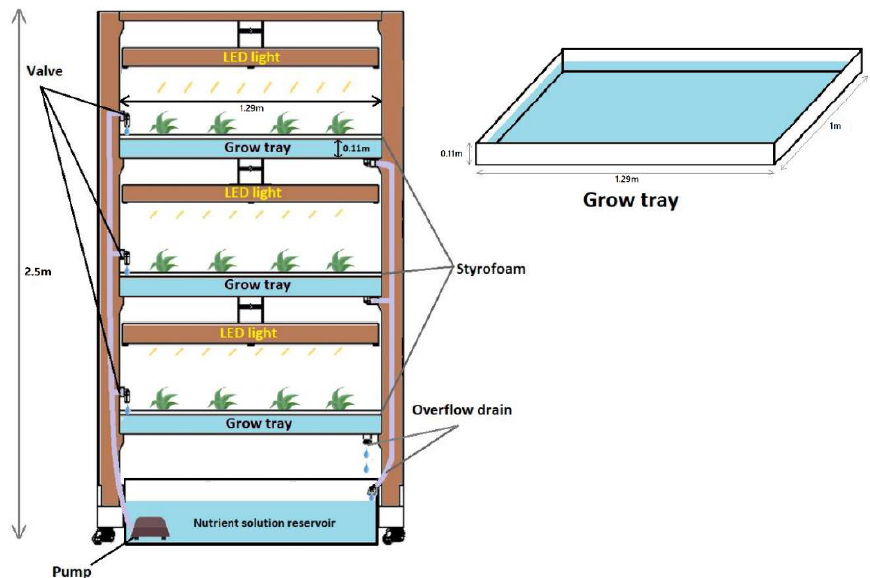
Figure 1. A deep flow technique (DFT) system in a plant factory. The plants were cultivated on a styrofoam board and placed on the surface of the nutrient solution with dissolved indole-3-acetic acidand the control treatment (without dissolved IAA).